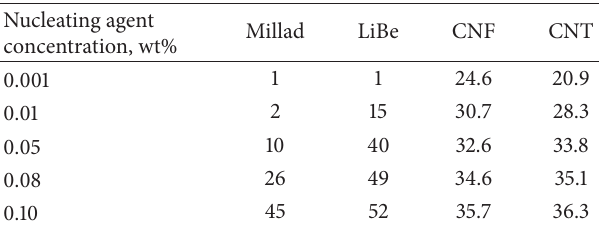
Table 3: Nucleating efficiency [%] of the four different nucleating agents on iPP composites as a function of concentration.